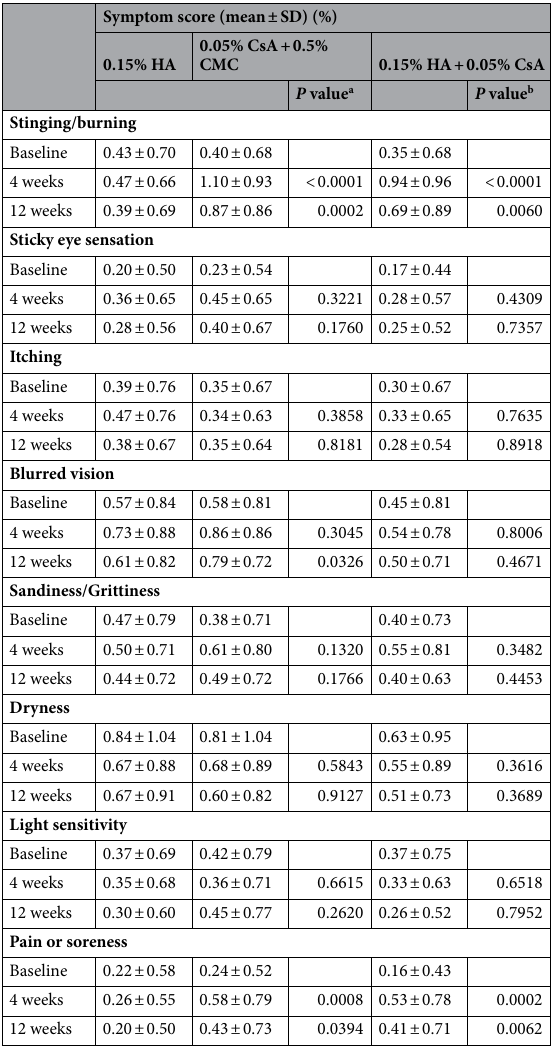
Table 1. Tolerability evaluation at baseline, 4, and 12 weeks in the safety set group. A score of 0 = no symptoms, a score of 4 = always had symptoms. SD standard deviation, HA hyaluronic acid, CsA cyclosporine A, CMC carboxymethylcellulose. a Difference between the 0.15% HA and 0.05% CsA + 0.5% CMC group (Wilcoxon rank sum test). b Difference between the 0.15% HA and 0.15% + 0.05% CsA group (Wilcoxon rank sum